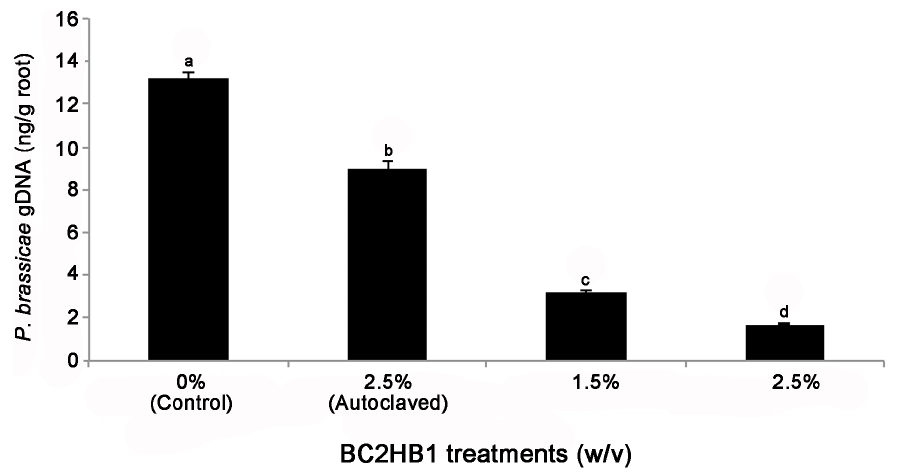
Figure 2. The effect of BC2HB1 treatments on the amount of Plasmodiophorabrassicae in canola roots (ng DNA/g fresh root, qPCR) at 14 days after seeding. The BC2HB1 formulation was incorporated at 1.25% or 2.5% (w/v) into the planting mix prior to seeding and resting spores